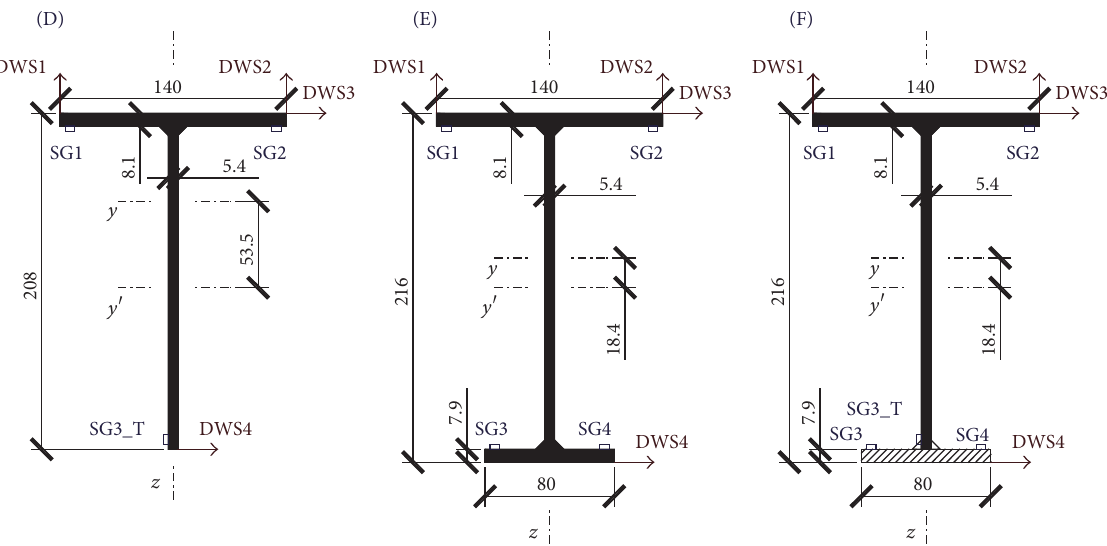
Figure 2: Column sets with dimensions, axes, strain gauge (SG) positions, and draw wire sensors (DWS) positions.